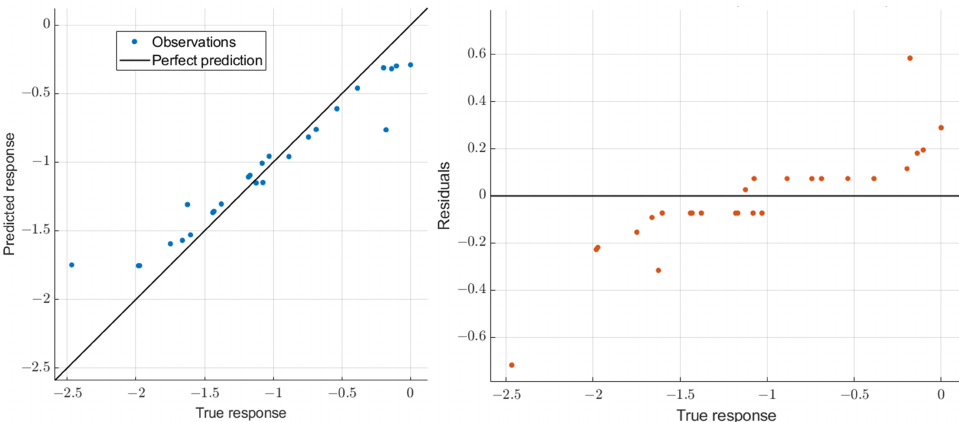
Figure 9. Sample plots of true response vs. predicted response and residuals for predictions with SVR for male participants in sex-specific Analysis—Case